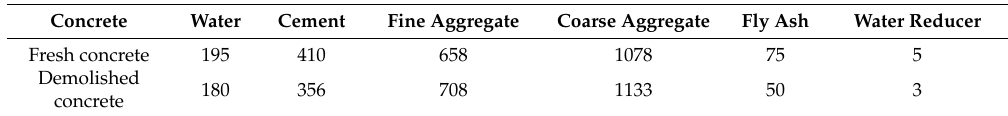
Table 2. Concrete mix proportions (kg/m 3